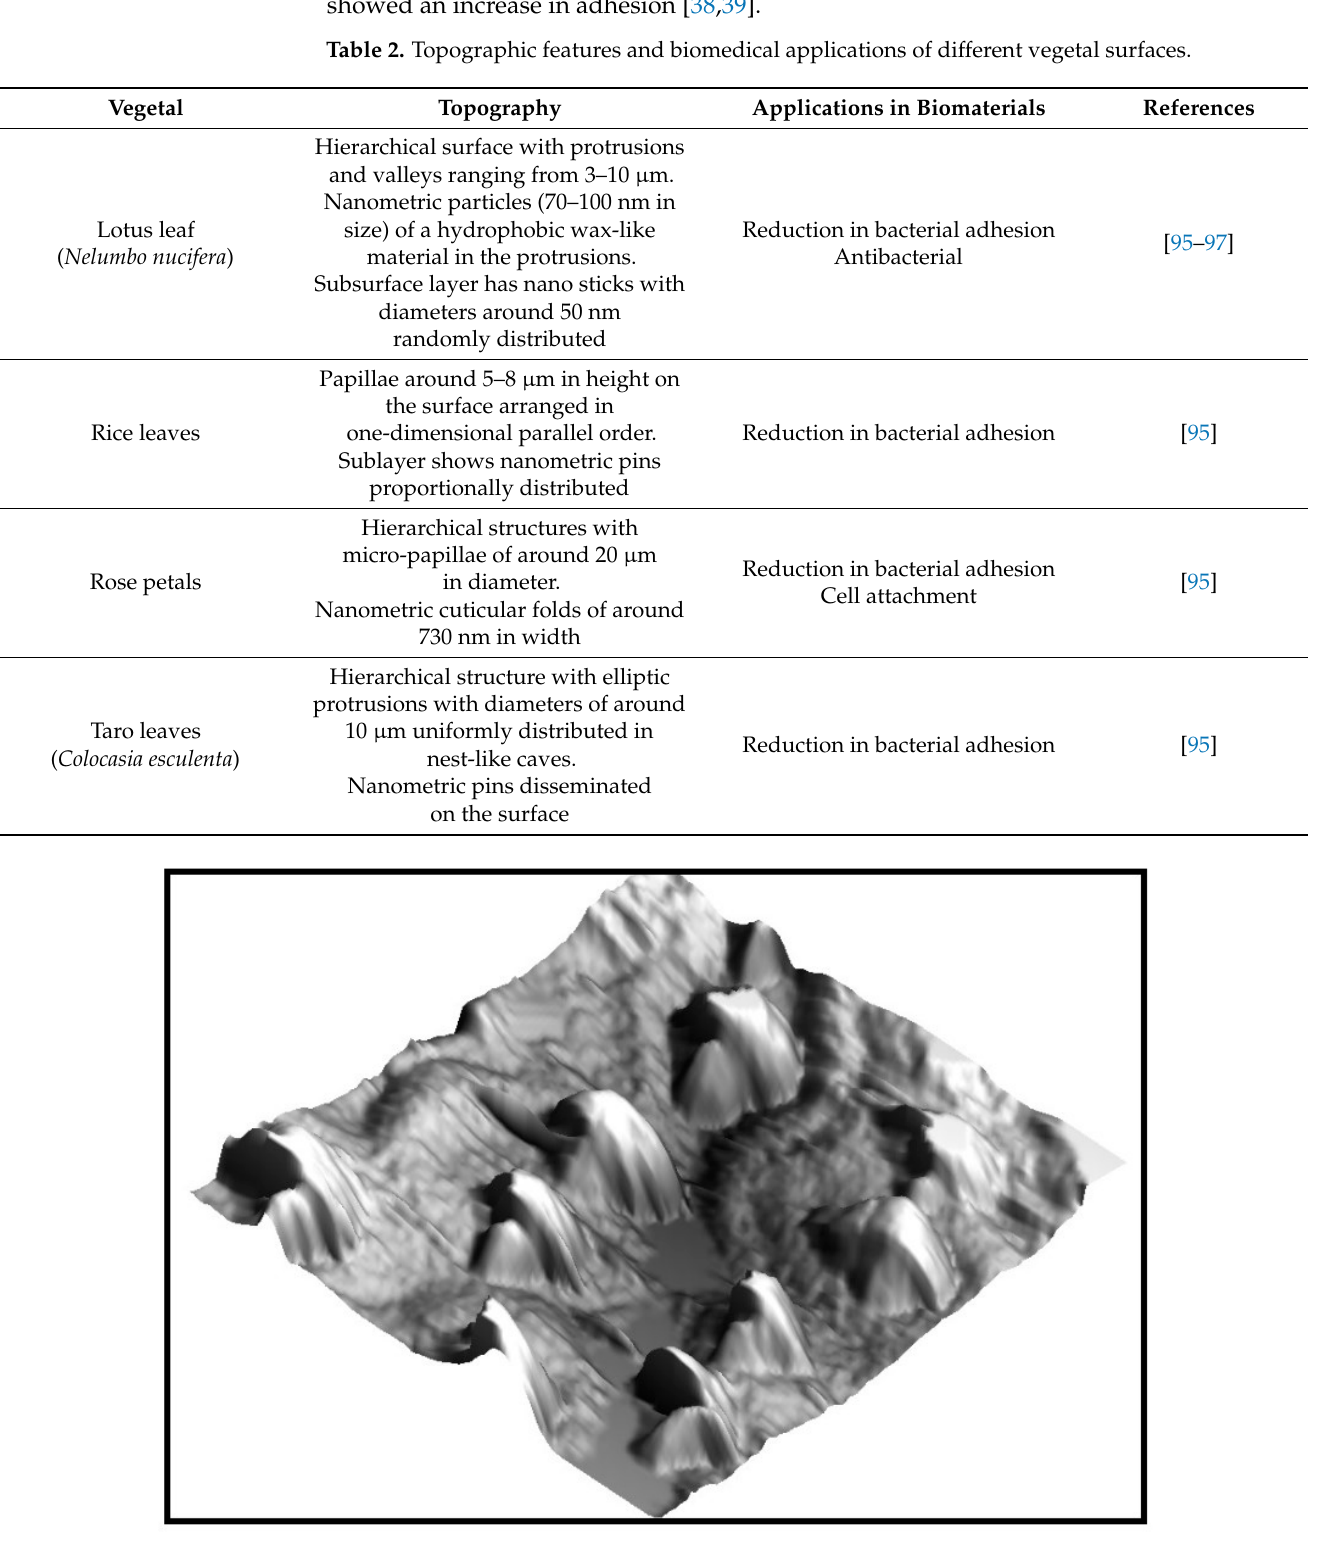
Figure 6. AFM image of the surface of C.